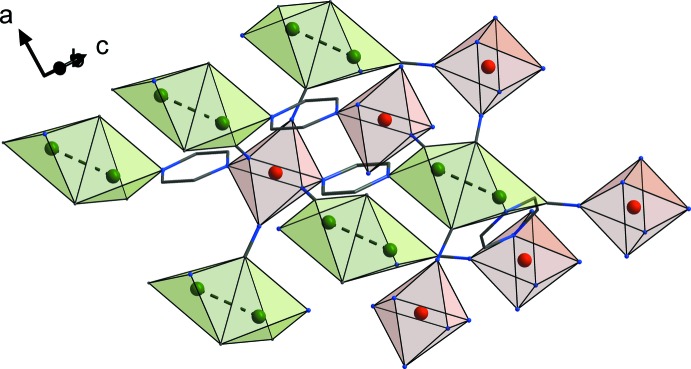
Coordination polyhedra of the Fe and Cu atoms in the title compound. Cu⋯Cu contacts are shown as dashed lines. Colour code: Fe red, Cu green, C grey, N blue.